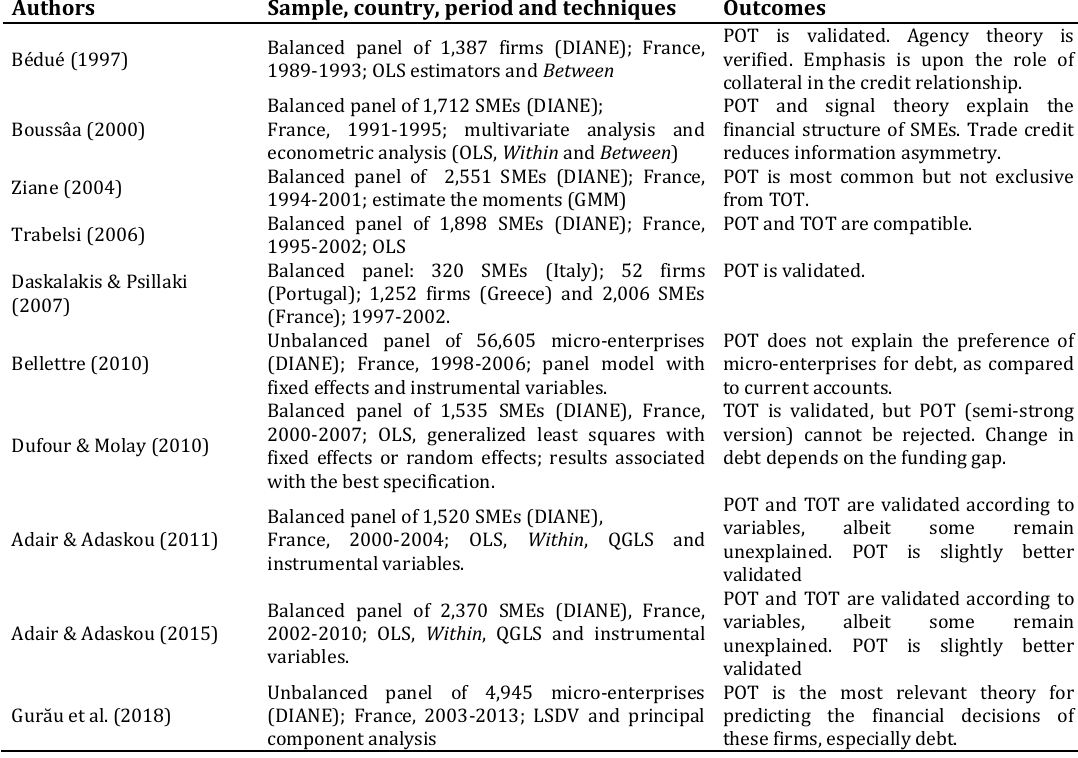
Table A1: an overview of studies upon the capital structure of French SMEs Authors